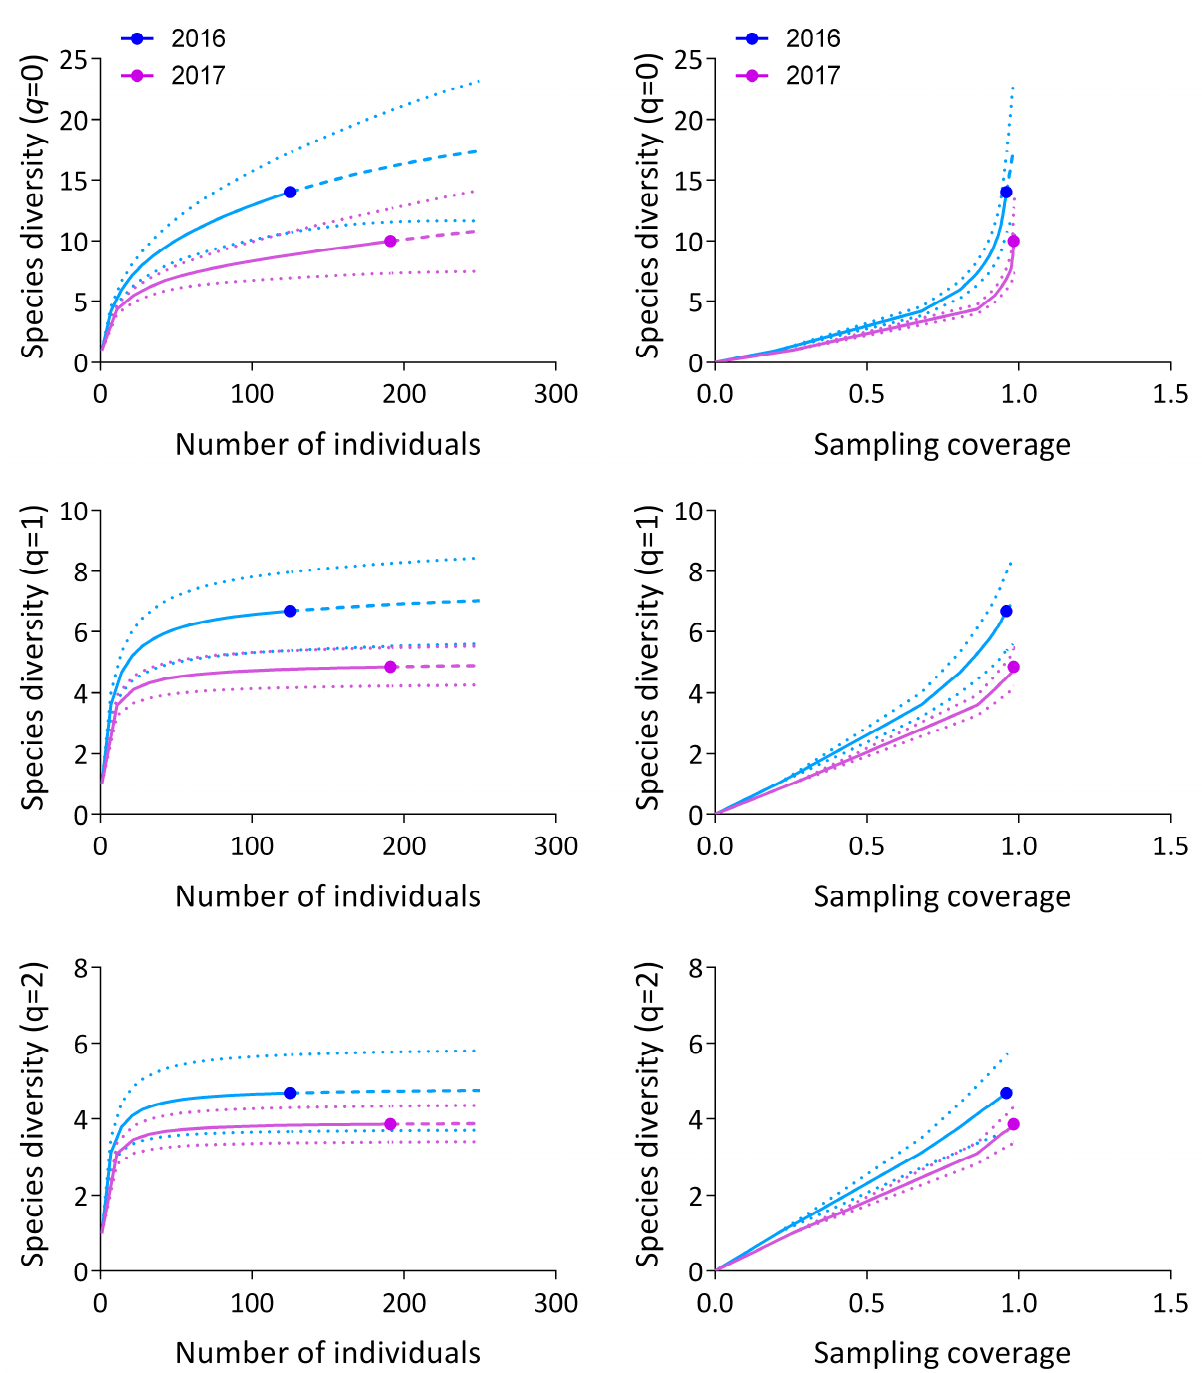
Figure 2. Interpolation (continuous lines) and extrapolation curves (discontinuous lines) of species diversity orders q = 0, 1 and 2, based in number of individuals ( left panel ) and sampling coverage ( right panel ) for Chamela in 2016 (blue line) and 2017 (purple line).